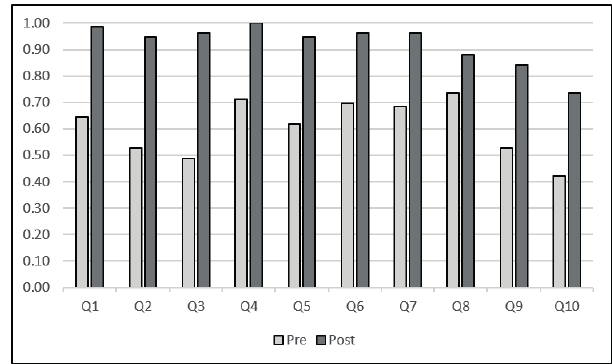
Figure 4. Pre and post scores before and after demonstration of the Kamel’s paper model of middle